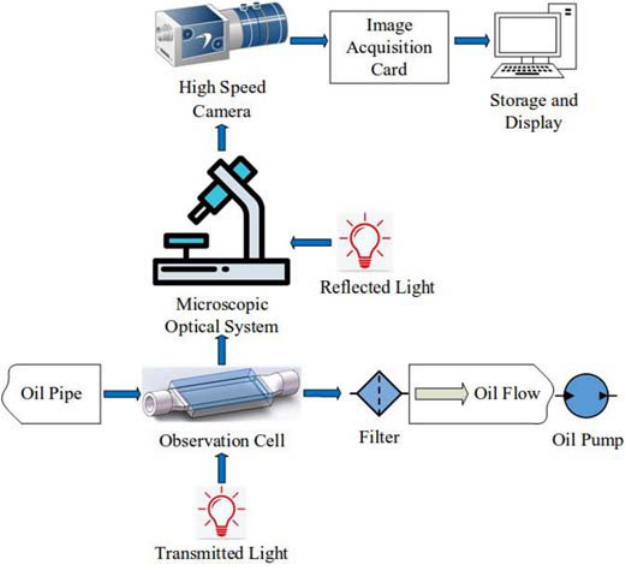
Fig. 1. Online optical image monitoring